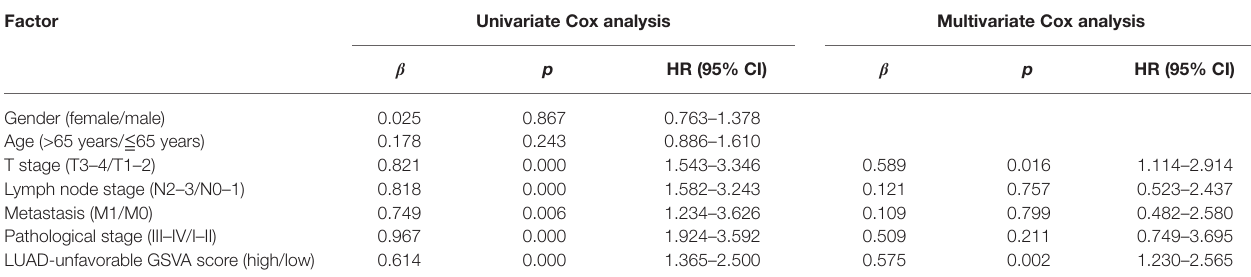
TABLE 2 | Univariate and multivariate analyses of LUAD-unfavorable GSVA score.